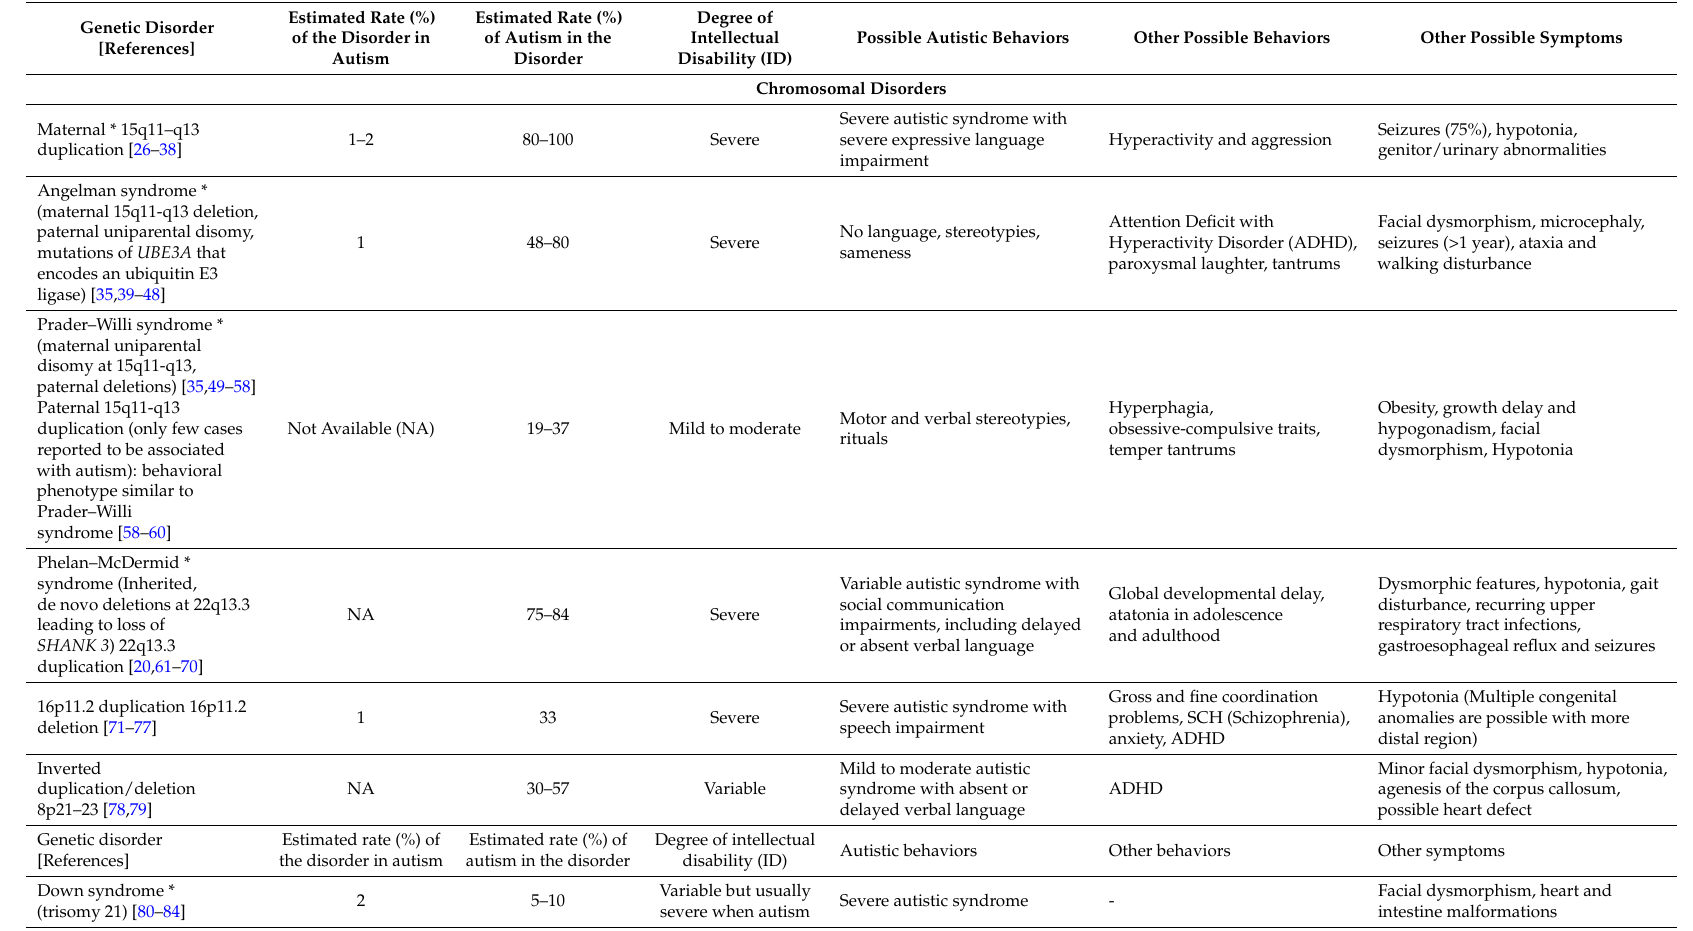
Table 1. Main genetic disorders associated with autistic